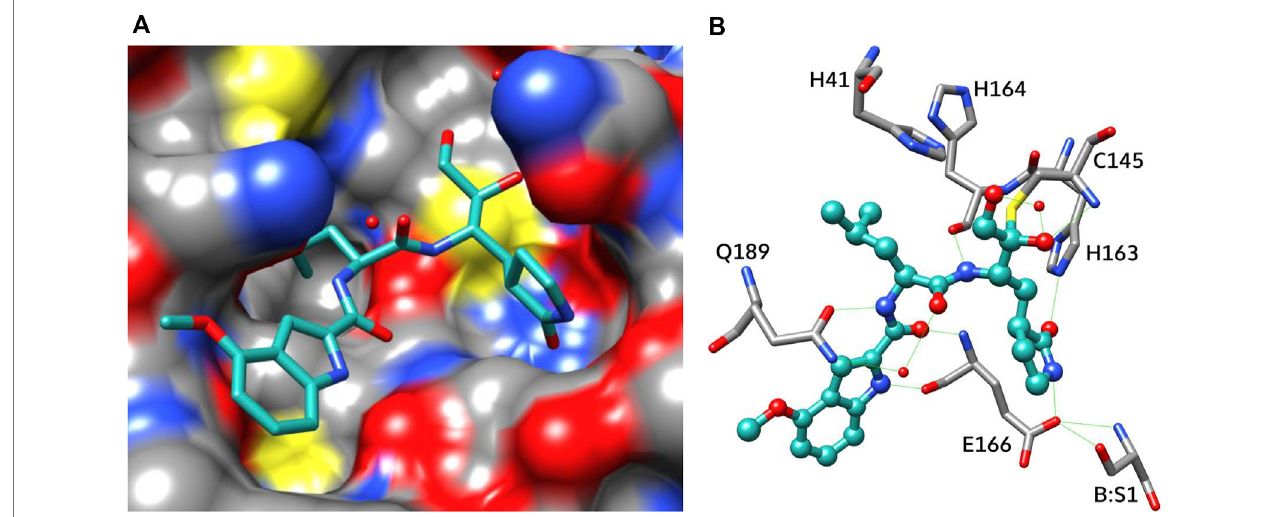
FIGURE 6 | Binding mode of PF-00835231 (PDB ID 6XHM): surface representation (A) and an interaction scheme (B) . The inhibitor molecule is shown as a ball- and-stick model, water molecules as red balls, and hydrogen bonds as green lines.